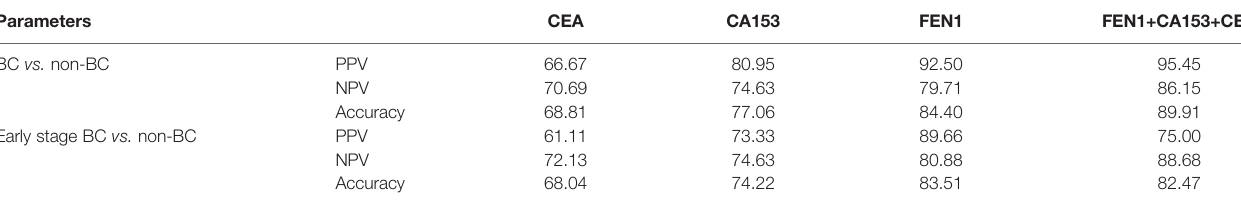
TABLE 2 | Positive predictive values, negative predictive values and accuracies for the detection of BC using markers (%). Parameters CEA CA153 FEN1 FEN1+CA153+CEA BC vs.